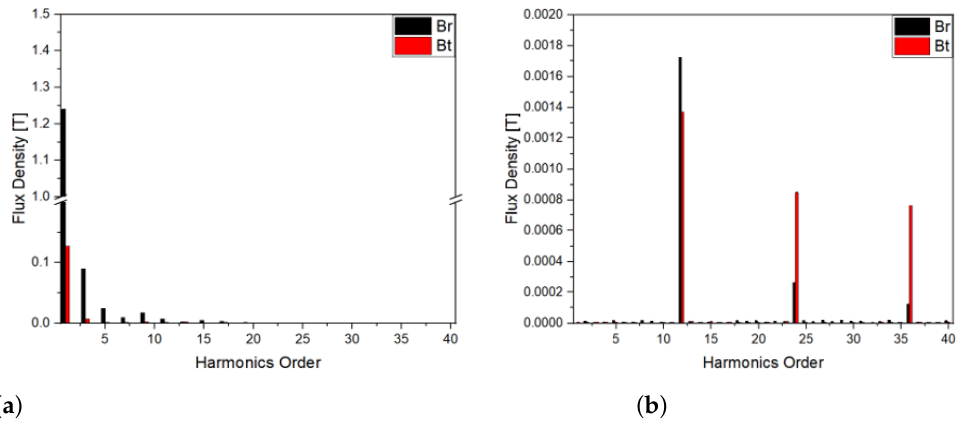
Figure 8. Sample of harmonic orders of flux density: ( a ) Point1 (stator) ( b ) Point2